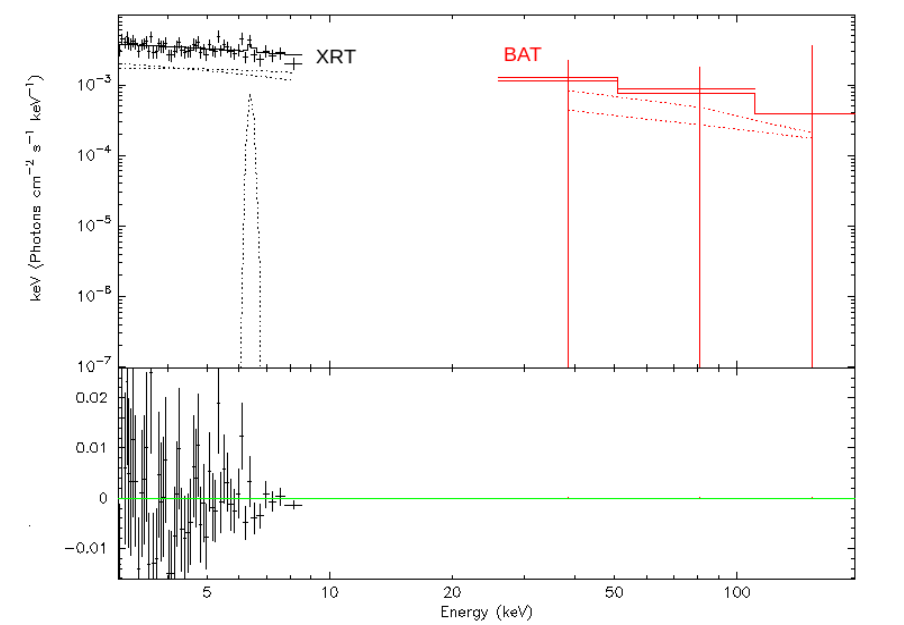
Figure A2. Unfolded SWIFT XRT and BAT spectra of 3C 111 during 2nd observational period (April 2007) and model. Above: all the spectra are shown by crosses; fitting curves are shown by solid lines; model components are shown by dotted lines; below: data residuals. During this period jet base emission was dominating slightly over nuclear one; signs of weak Fe-K α emission line are